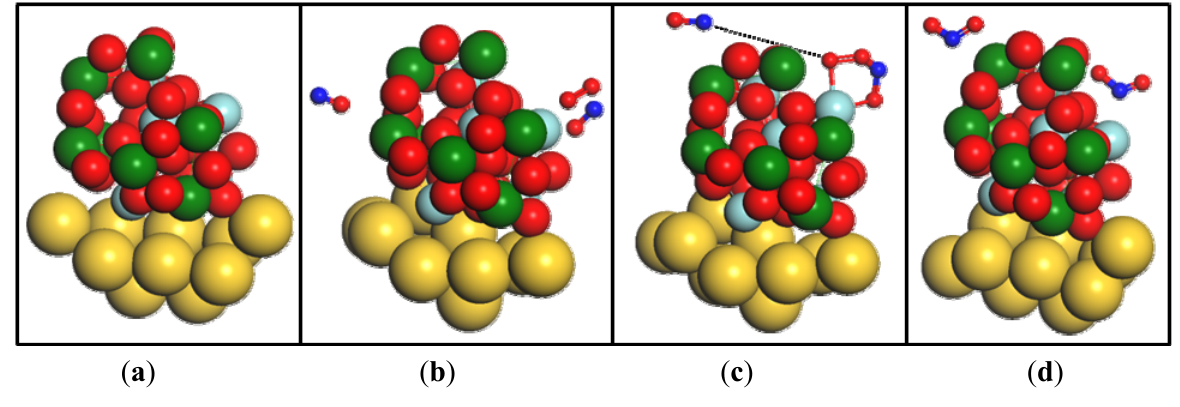
Figure 7. Ground state conformations of the ( a ) YSZ/Au model cluster, ( b ) reactant of Equation (3) (YSZ/Au cluster with 2NO and O ( d ) product of Equation (3) (YSZ/Au cluster with 2NO ● : N, and ● :